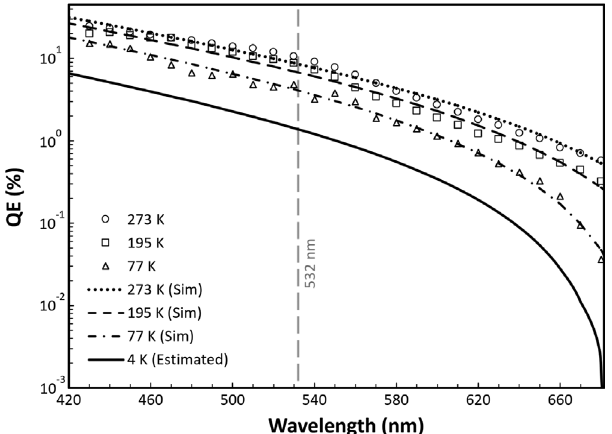
FIG. 5. Measured QE spectral response for the Cs cathode grown on the Nb substrate for the indicated temperatures: circles, ice water; rectangle, dry ice; triangles, liquid nitrogen. The dashed lines through QE data points correspond to fits based on Fowler ’ s model (see the text). The solid black line is a simulated o spectral response using the photoemission threshold V parameter B extrapolated to 4 K. The vertical dashed line at 532 nm indicates a QE of 1.4% at 4 and B values to 4 K. o